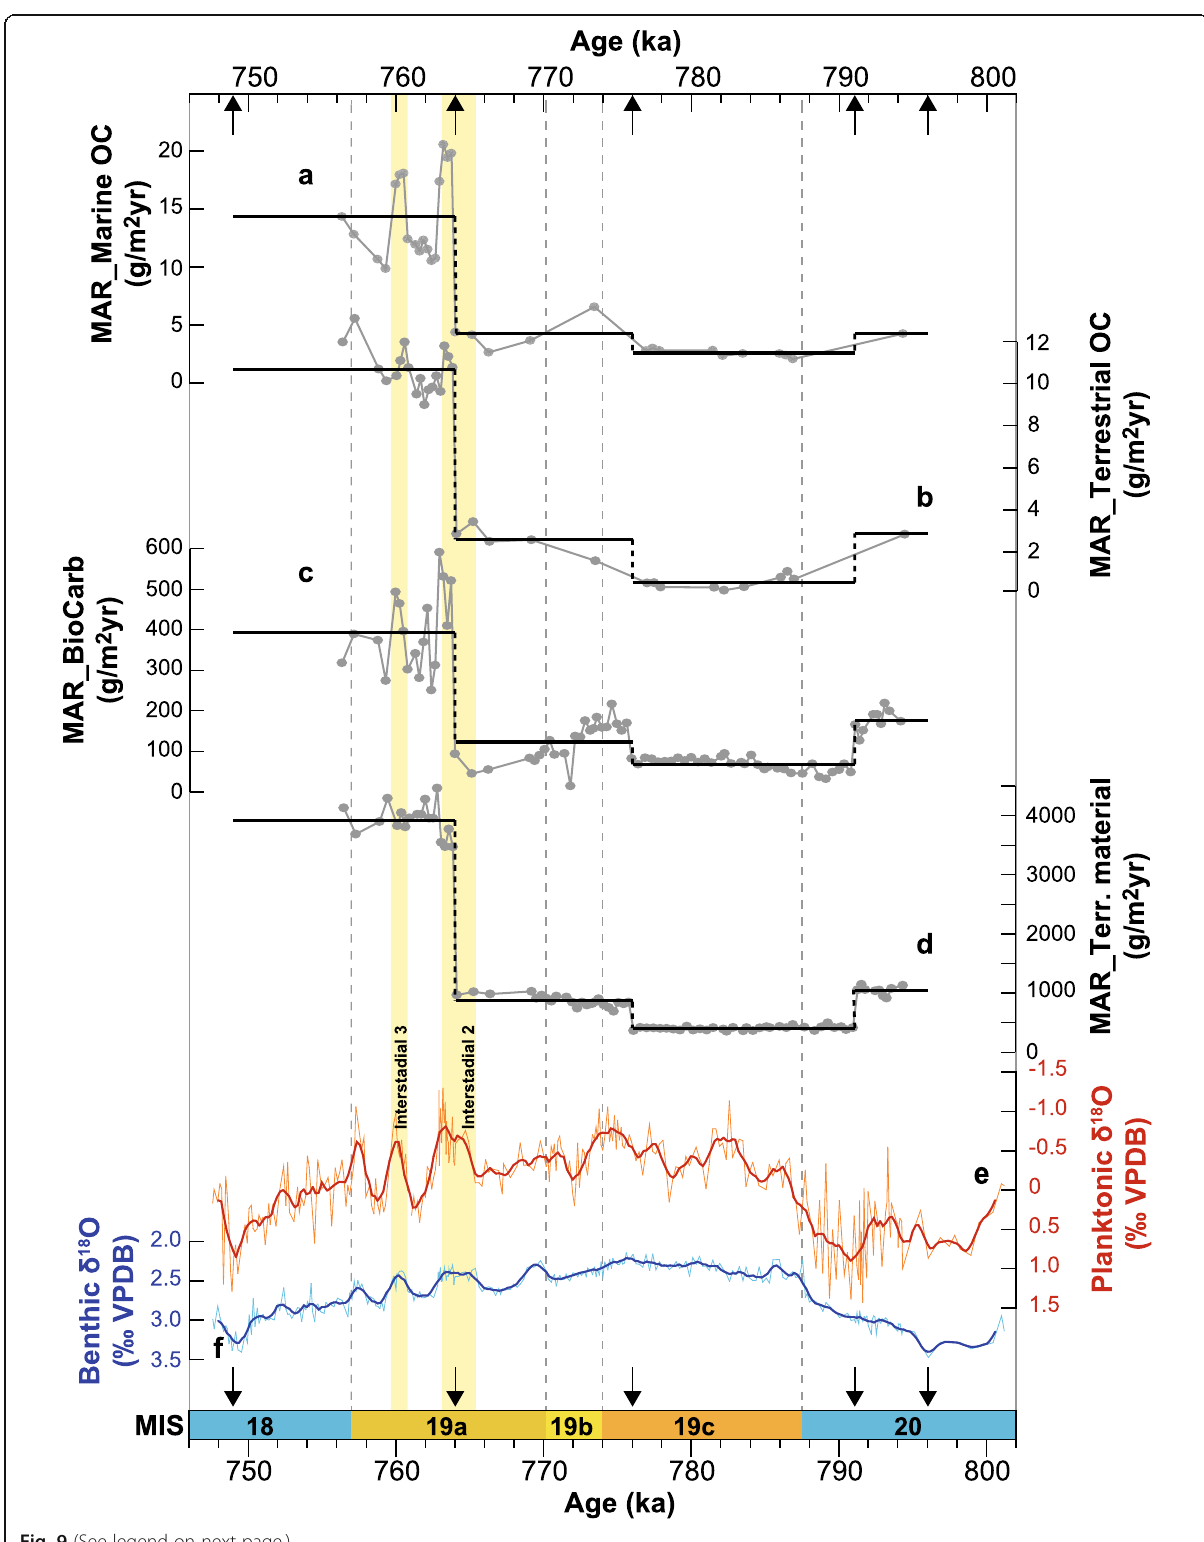
Fig. 9 (See legend on next